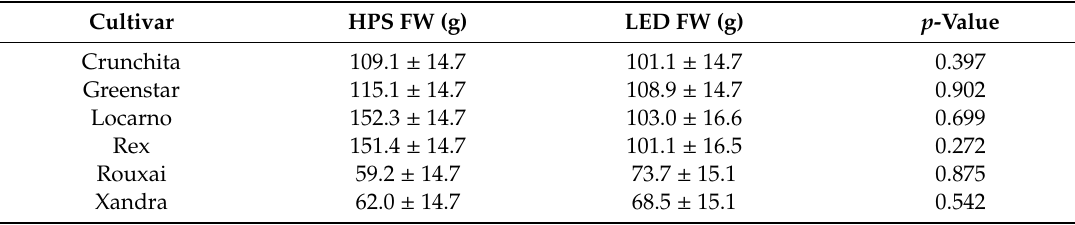
Table 10. Fresh weight of the six lettuce cultivars in phase 2 under HPS versus LED greenhouse supplemental lights. Data are means ± standard error (SE) of circa 72 plants from three crop cycles. A t -test was used to compare the FW of HPS versus LED within a cultivar ( p -value). Tukey’s HSD was omitted as all cultivars and treatments fell within the same